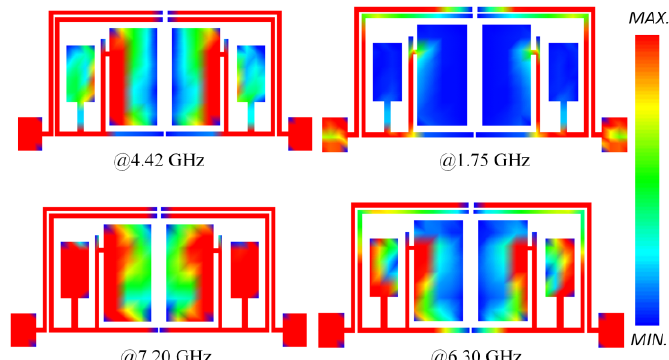
Figure 7. Current density distributions of the proposed dual-band BPF.